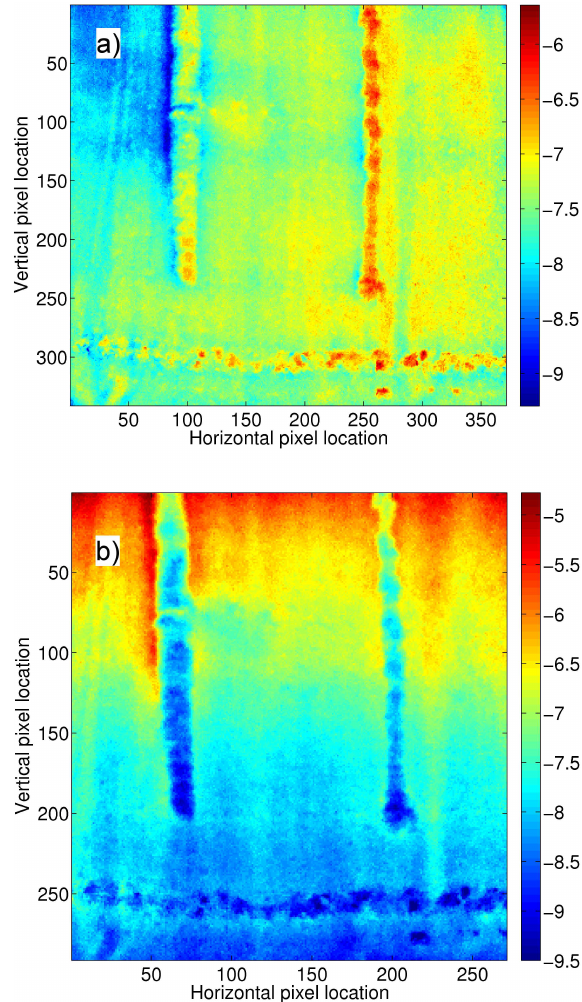
Fig. 8. Snow temperature reacting on changing air temperatures in the cold lab.